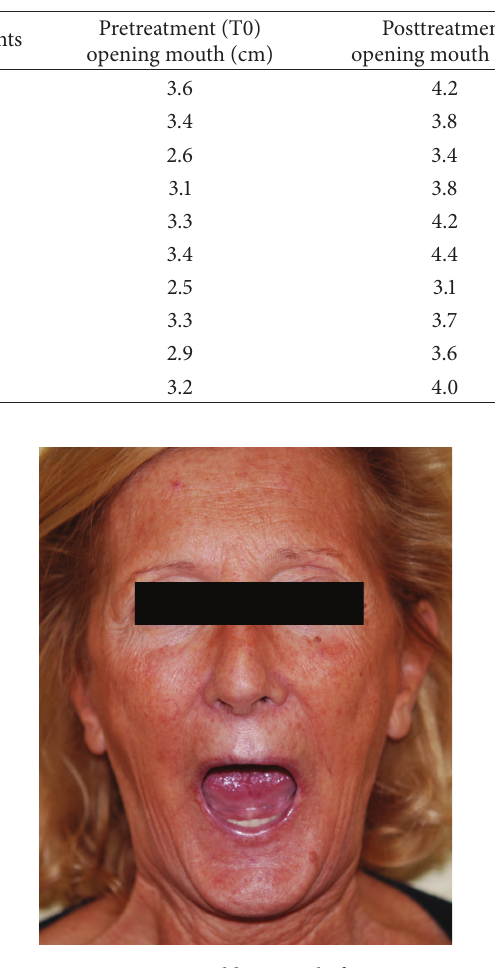
Figure 7: A 48-year-old woman before